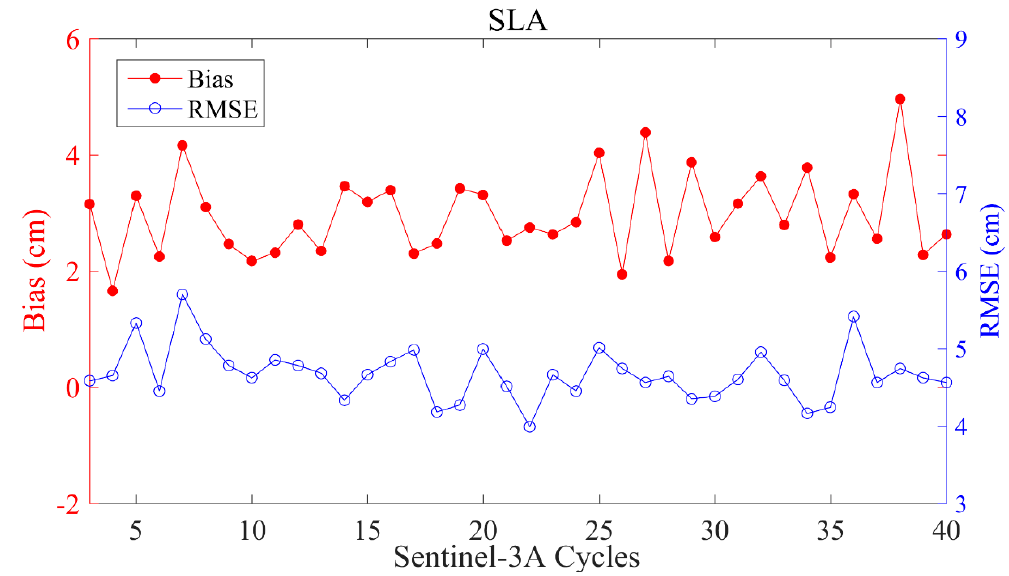
Figure 22. Cycle by cycle biases and RMSEs of SLA differences at dual-crossovers between Sentinel-3A and Jason-3 with measurement time difference of 30 minutes.